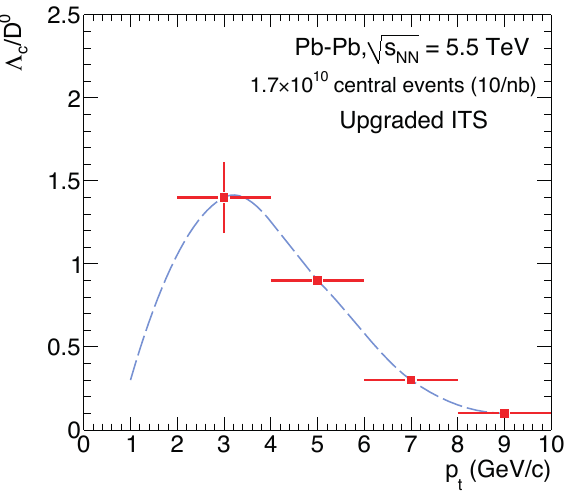
Figure 3. Possible measurement with the upgrade of the Λ c / D 0 ratio as a function of p T for central Pb–Pb collisions. The points are drawn on a line that captures the behaviour of the measured Λ / K 0 S